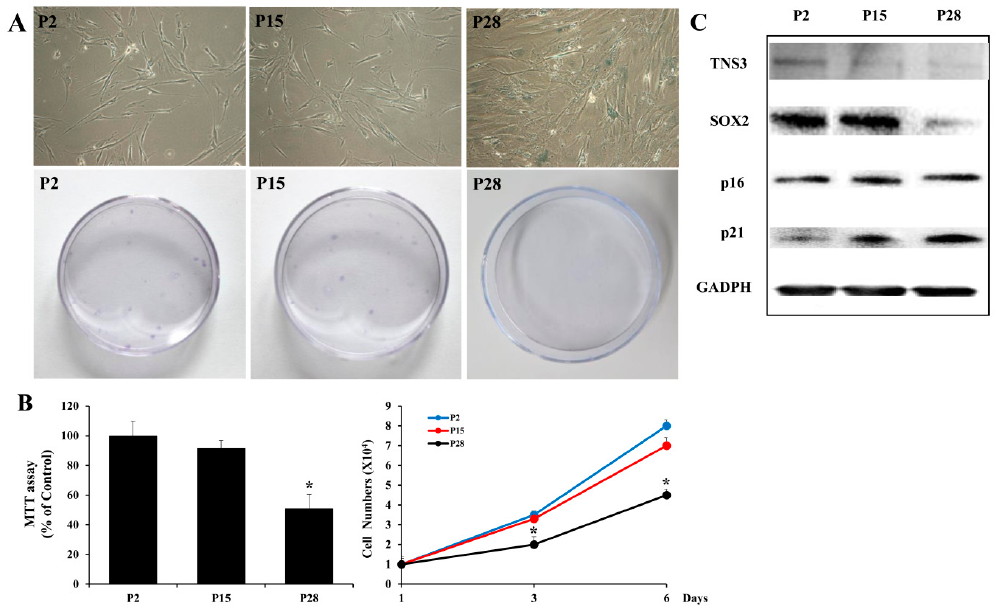
Figure 3. TNS3 is involved in regulating TMSC senescence. ( A ) Beta-galactosidase staining and colony-forming unit assay were performed in early, intermediate, and late passages of TMSCs. ( B ) MTT assay was conducted to evaluate the proliferation of TMSCs at different passages. ( C ) Protein expression of TNS3, SOX2, p16, and p21 was detected in TMSCs at different passages by Western blotting. *, p < 0.05 compared to the control. n = 3. Columns and error bars represent the mean ± standard deviation.